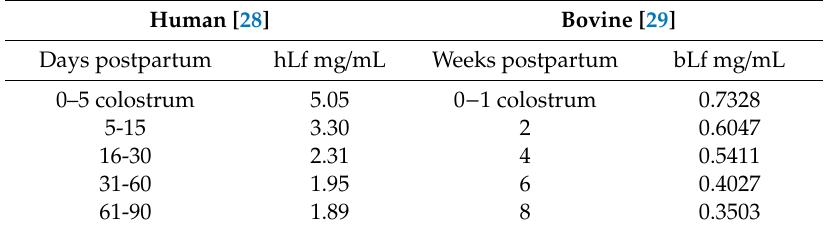
Table 2. Fluctuations on lactoferrin levels in postpartum mammary gland